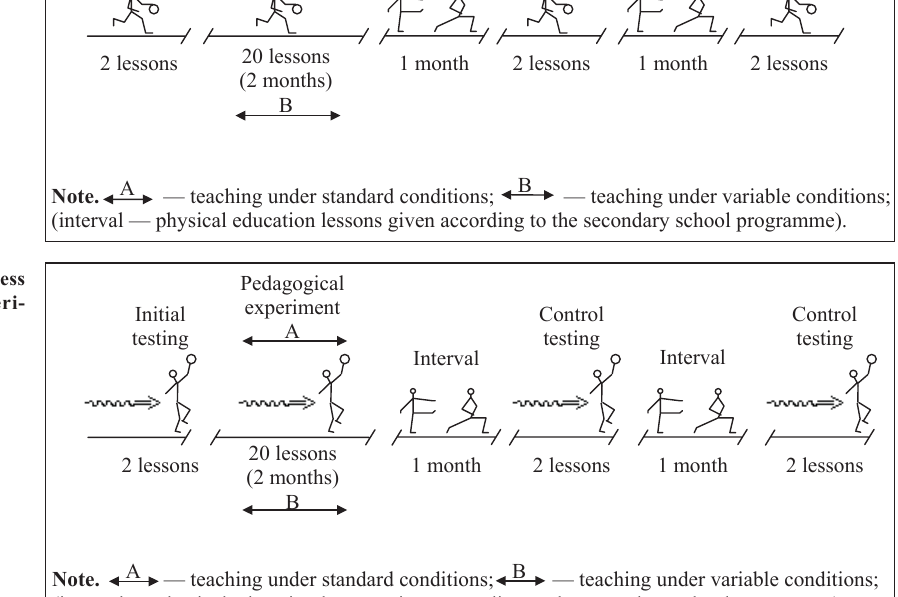
Fig. 2. The scheme of the progress of the second stage of the experi- ment